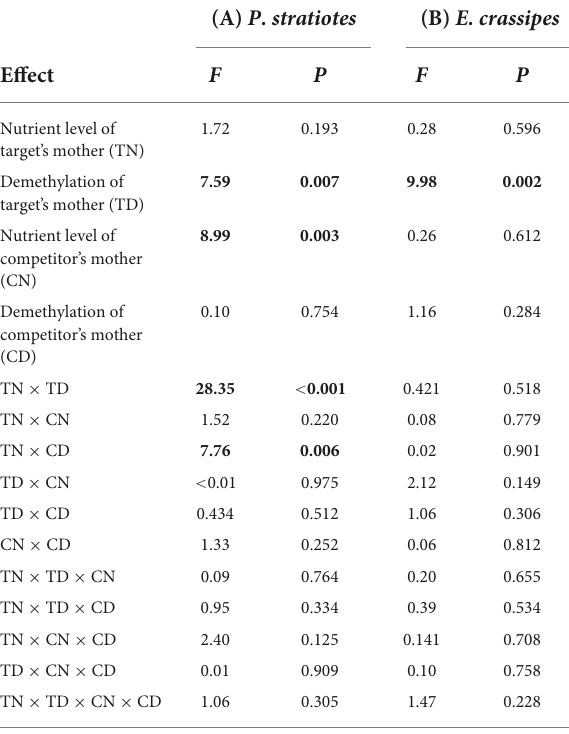
TABLE 2 Effects of nutrient level and DNA demethylation of the target‘s mother and the competitor’s mother on the interspecific competitive response (LnRR) of the target plant of (A) Pistia stratiotes and (B) Eichhornia crassipes in the second experiment. (A) P. stratiotes (B) E. crassipes